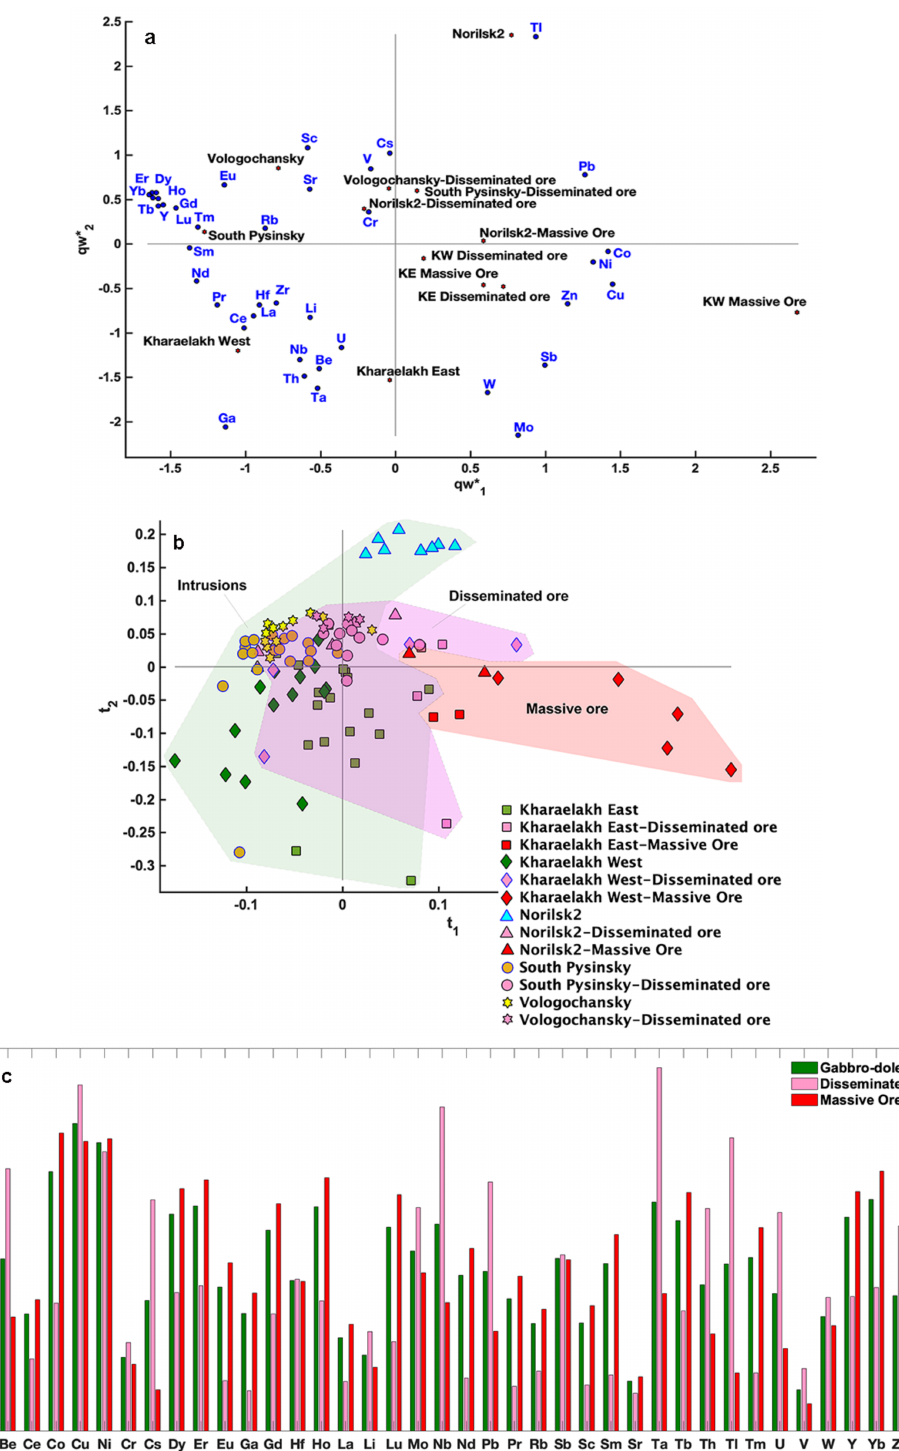
Figure 10. Partial least-squares discriminant analysis (PLS-DA) of the trace and minor elements data in the samples from the different studied gabbro–dolerite intrusions and their associated disseminated and massive ores. ( a ) The qw* 1 –qw* 2 (first and second loadings) plot shows the correlations among the elemental variables and their relationships with the different sample classes. ( b ) The t 1 –t 2 (first and second scores) plot shows the distribution of the analyses from different mineralized and nonmineralized samples in the latent variable space defined by qw* 1 –qw* 2 . The colored polygons delimit the three main fields formed by the intrusion, disseminated ore and massive ore data points. ( c ) The variable importance on projection (VIP) plot shows the level of importance of the different oxides in the classification of the different